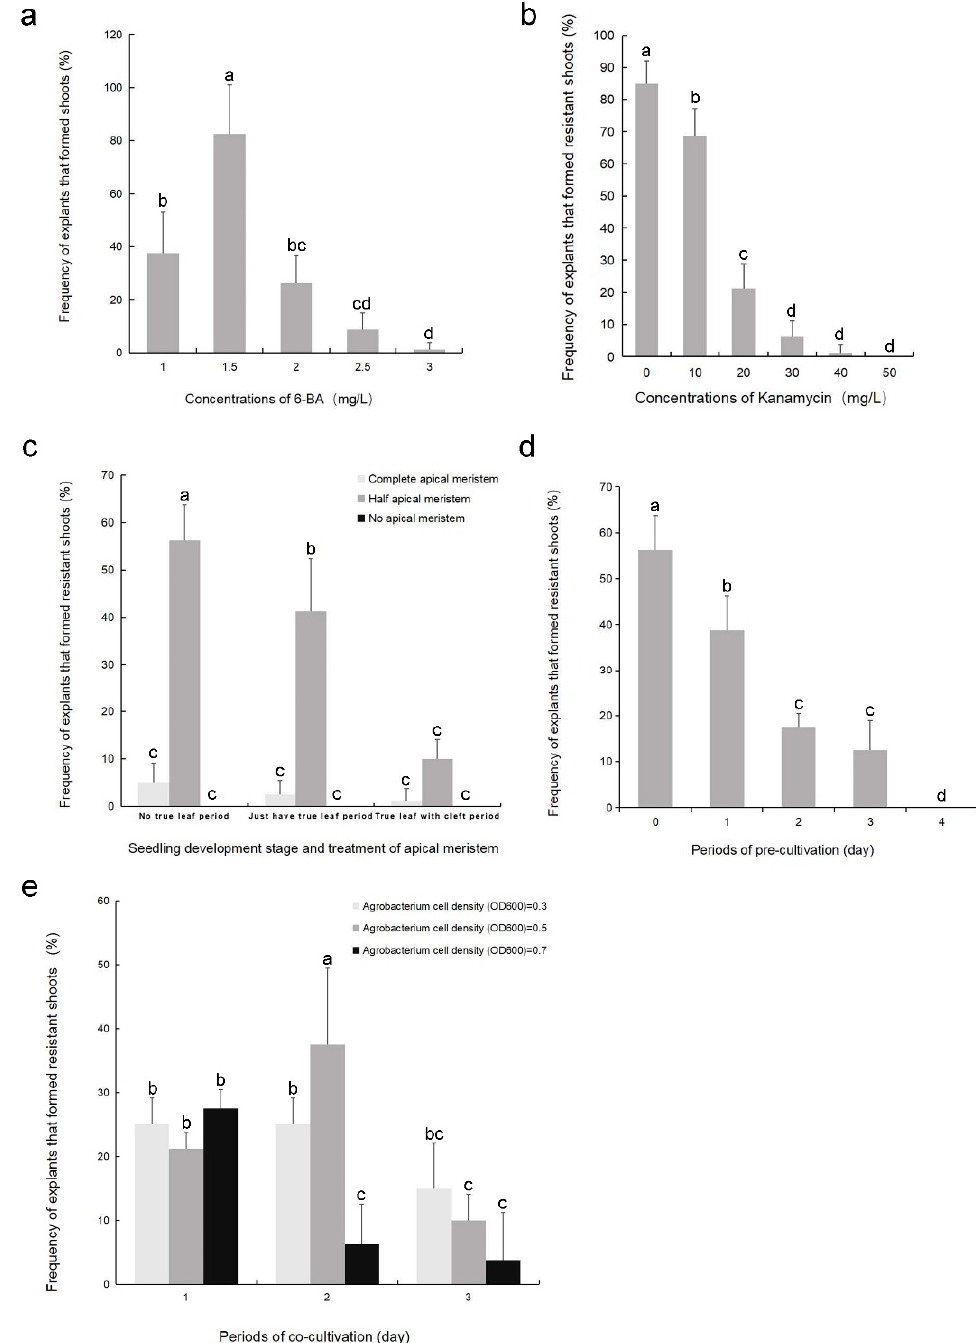
Figure 1. Factors affecting the efficiency of pyrethrum shoot induction and transformation. Effects of ( a ) 6-benzylaminopurine (6-BA) concentration on shoot induction, ( b ) kanamycin concentration on shoot induction, ( c ) explant status on transformation, ( d ) preculture duration on transformation, and ( e ) cocultivation period and the concentration of A. tumefaciens on transformation. Bars indicate the mean ± SD. Bars with a different lower-case letter are significantly different (LSD test, p < 0.05).